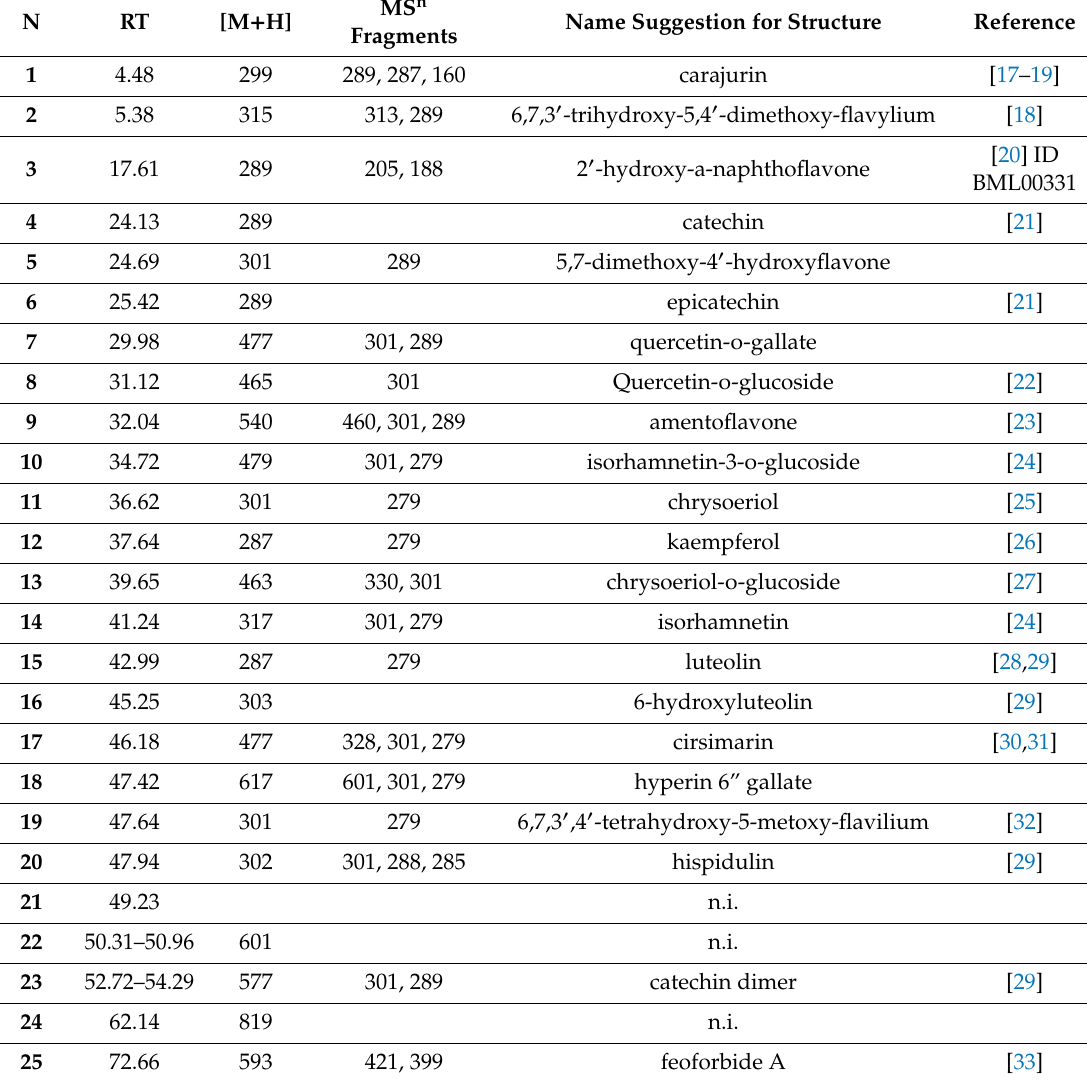
Table 1. HPLC-PDA-ESI-IT-MS / MS data (detected UV-vis and detected ions) and FIA-ESI-IT-MS / MS n (product ions) of compounds detected in the A. chica leaves hydroethanolic